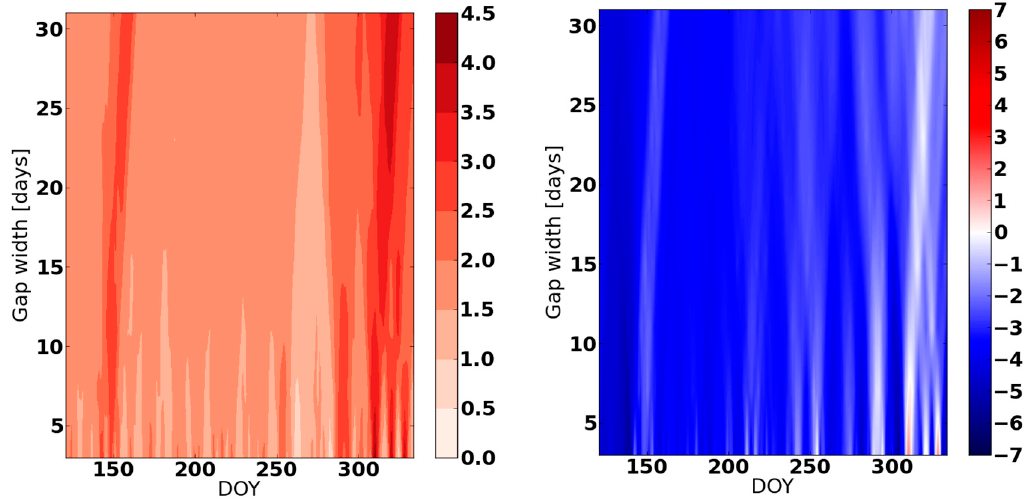
Figure 9. RMSE DEB ( left panel ) and (RMSE DEB -RMSE ERA5 ) difference ( right panel ) for DOY 121–334 in 2017 in Gumpenstein (Austria).